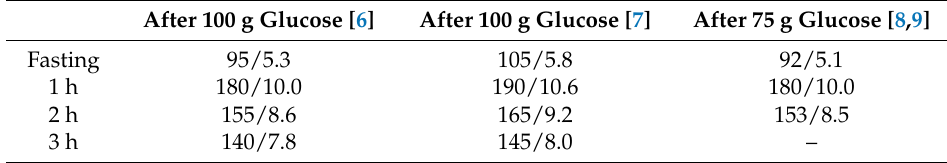
Table 1. Diagnostic criteria for gestational diabetes based on plasma glucose concentrations after an oral glucose tolerance